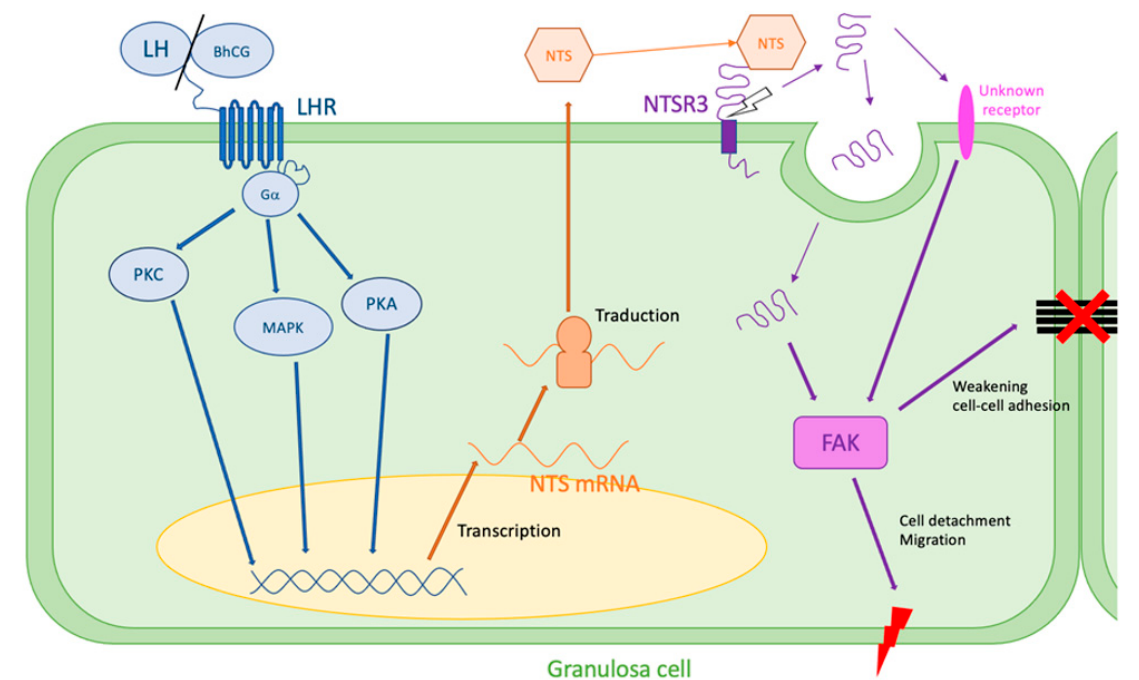
Figure 2. Hypothesis of NTS action during ovulation. LH surge stimulates NTS expression by the granulosa cells via MAPK, PKA, and PKC pathways. NTS acts on NTSR3 in an autocrine way. NTSR3 stimulates FAK pathway, which weakens cell–cell and cell–extracellular matrix adhesions and can lead to follicular rupture. FAK: focal adhesion kinase, LH: luteinizing hormone, LHR: LH receptor, MAPK: mitogen-activated protein kinase, PKA: phosphokinase A, PKC: phosphokinase C, NTS: neurotensin, NTSR3: sortilin.